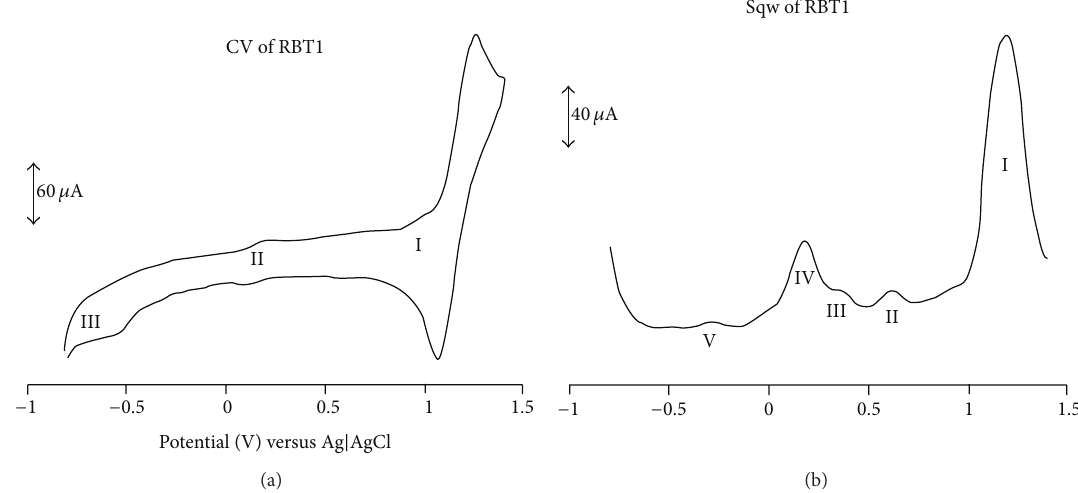
Figure 3: Cyclic and square wave voltammetry profiles of 1 × 10 −3 M of RBT1 in freshly distilled DMF containing 0.1M TBABF 4 supporting electrolyte. Step potential: 5mV, amplitude: 50 mV versus Ag | AgCl, frequency: 10Hz. Scan rate: 100m Vs −1 versus Ag | AgCl.